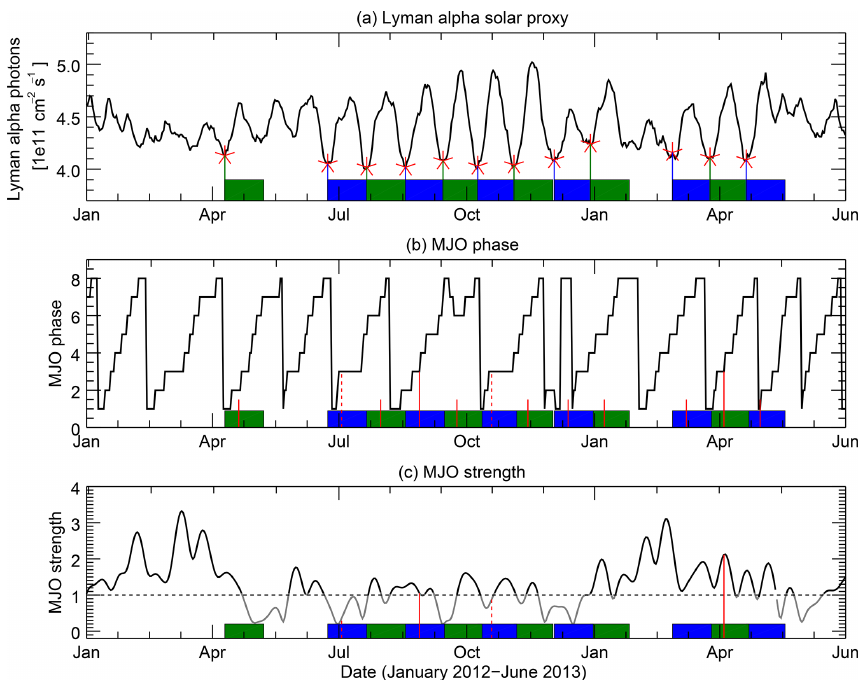
Figure 1. Examples of the analyzed time series for the period January 2012 to June 2013. The Lyman alpha solar proxy (a) shows pronounced 27-day variability, particularly in the middle of this period. The MJO phase evolution ( b ; here represented by the OMI index) shows the expected periodic transitions from phase 1 to phase 8. However, it is obvious that the solar 27-day signal as well as the MJO phase evolution are definitely not perfectly periodic, but have to be considered as quasi-periodic processes (see Sect. 1). Strong variability also appears in the MJO strength ( c , OMI index). The figure also indicates the basic steps of the analysis routine: identified solar minima are marked with red stars in the top panel. The resulting 0- to 28-day time lag epochs are indicated by alternating green and blue shaded areas in all three panels. As an example of the following counting step, it is illustrated how often MJO phase 3 occurred 10 days after solar minimum. For this, all 10-day time lags are marked (all vertical red lines in panel b ). During 4 of these days, the MJO was in phase 3 (longer solid and dashed red lines). However, only days during which the MJO strength exceeded a particular threshold (here 1, horizontal dashed line in panel c ) are considered so that the analysis results in two occurrences of phase 3 for time lag 10 (longer solid vertical red